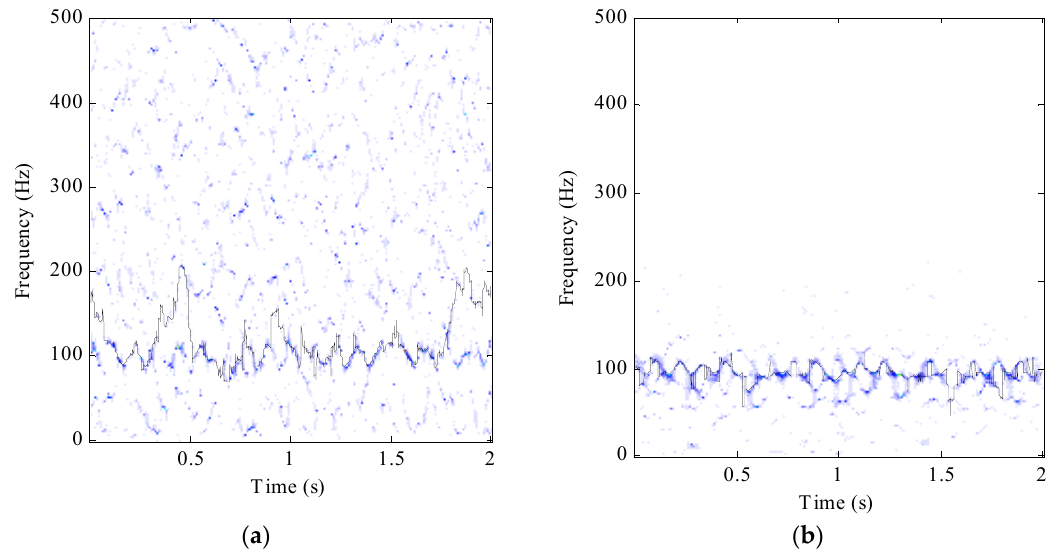
Figure 6. ( a ) TFR of simulated signal with − 5 dB by SST; ( b ) TFR of simulated signal with − 5 dB by the proposed method.